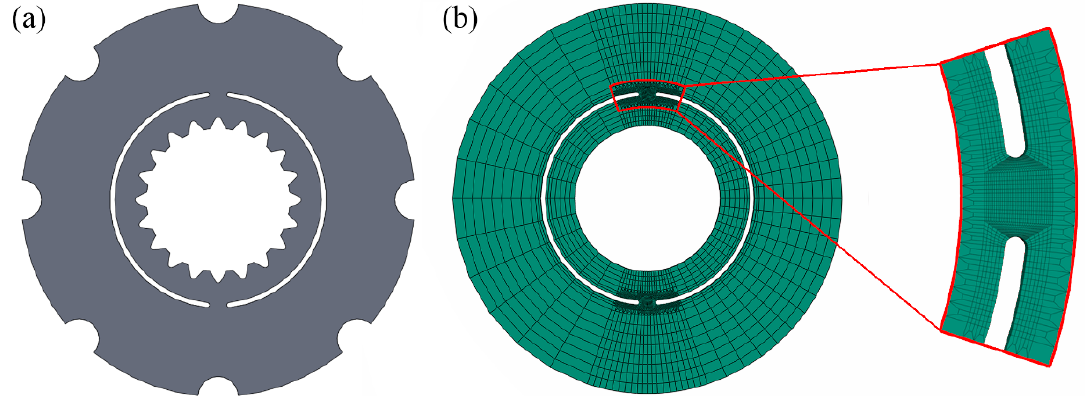
Figure 15. Schematic diagram of the twin bridge torsion shear specimen: ( a ) CAD model; ( b ) the simpli fi ed FE model.